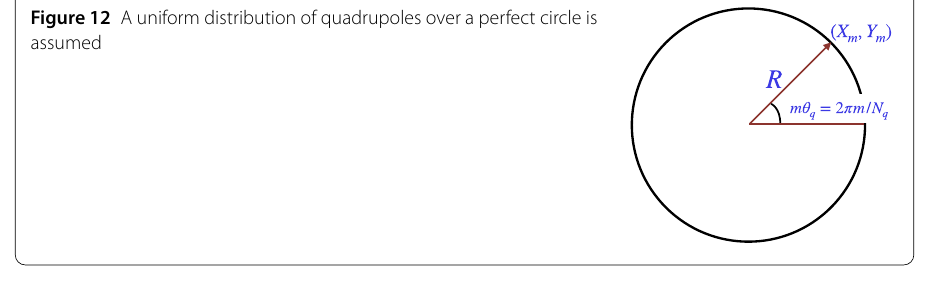
over quadrupoles